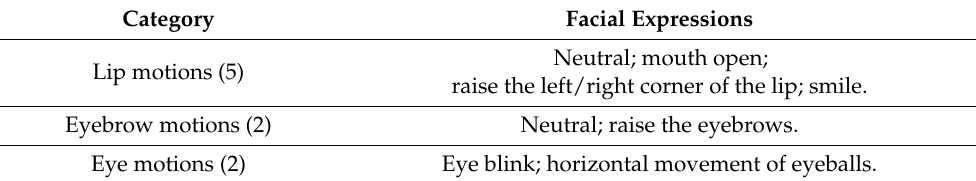
Figure 2. A schematic diagram of the experimental protocol. ( a ) Presentation of the next facial expression to the participant in a random order; ( b ) task performing step: the participant replicates the given facial expression repeatedly 3 times for 3 s; ( c ) a resting period lasting for 3 s. Table 1. List of predictable facial